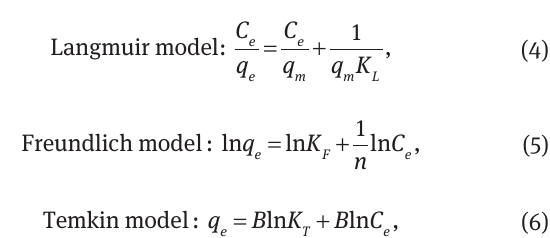
Figure 11: The plot of pseudo-second-order model of Fe microspheres.